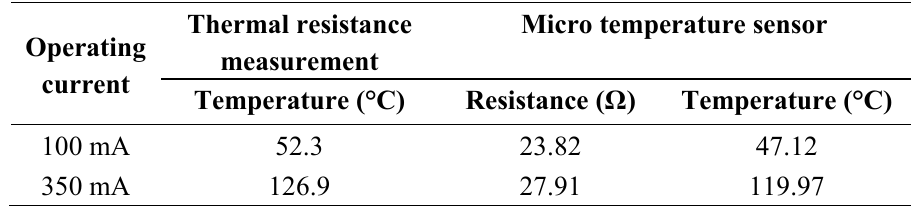
Table 1. Difference between measurements made using thermal resistance measurement technology and micro temperature